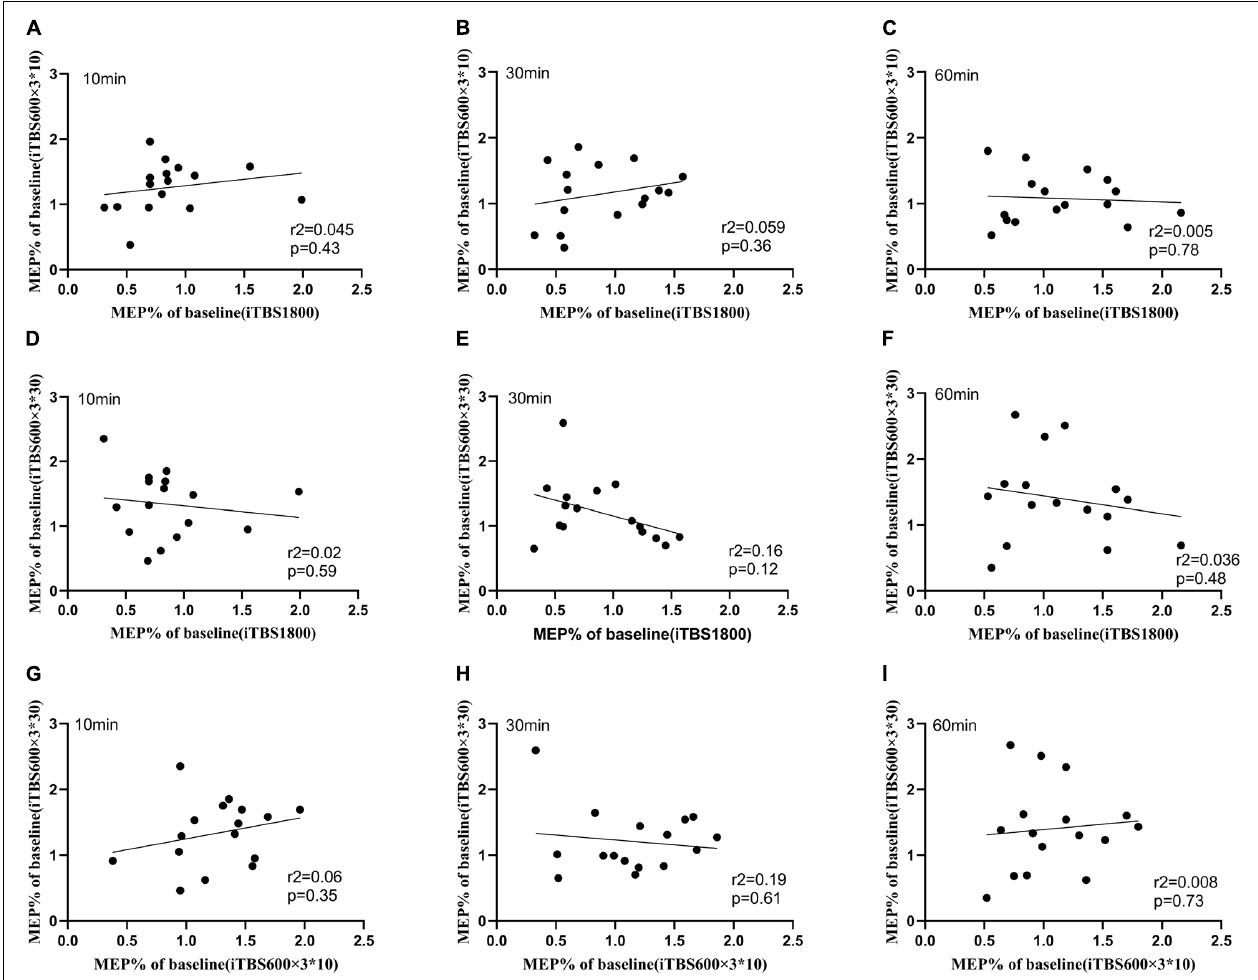
FIGURE 4 | Relationship between iTBS1800, iTBS600 × 3 ∗ 10, and iTBS600 × 3 ∗ 30 at time points 10, 30, and 60 min. Correlation between the normalized grand average MEPs amplitude following different iTBS conditions (A) MEPs amplitude correlation of iTBS1800 and iTBS600 × 3 ∗ 10 at 10 min (B) MEPs amplitude correlation of iTBS1800 and iTBS600 × 3 ∗ 10 at 30 min (C) MEPs amplitude correlation of iTBS1800 and iTBS600 × 3 ∗ 10 at 60 min (D) MEPs amplitude correlation of iTBS1800 and iTBS600 × 3 ∗ 30 at 10 min (E) MEPs amplitude correlation of iTBS1800 and iTBS600 × 3 ∗ 30 at 30 min (F) MEPs amplitude correlation of iTBS1800 and iTBS600 × 3 ∗ 30 at 60 min (G) MEPs amplitude correlation of iTBS600 × 3 ∗ 10 and iTBS600 × 3 ∗ 30 at 10 min (H) MEPs amplitude correlation of iTBS600 × 3 ∗ 10 and iTBS600 × 3 ∗ 30 at 30 min (I) MEPs amplitude correlation of iTBS600 × 3 ∗ 10 and iTBS600 × 3 ∗ 30 at 60 min.